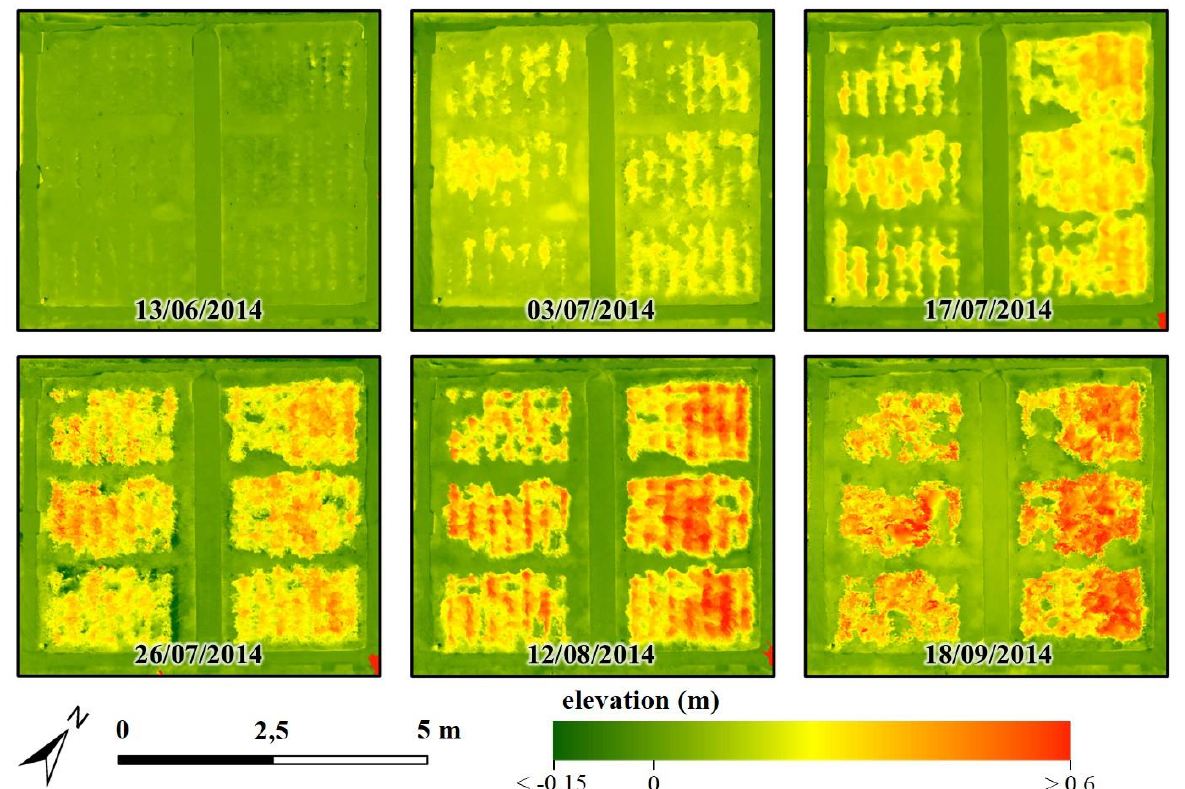
Figure 4: CSM of all acquisition dates in raster data